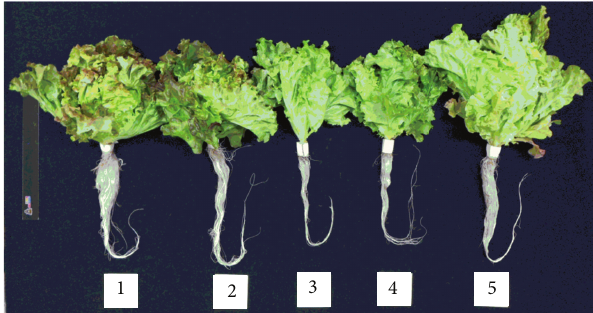
Figure 3: Growth of plant under solar light (1), IR cladding material (2), green cladding material (3), blue cladding material (4), and red cladding material (5).